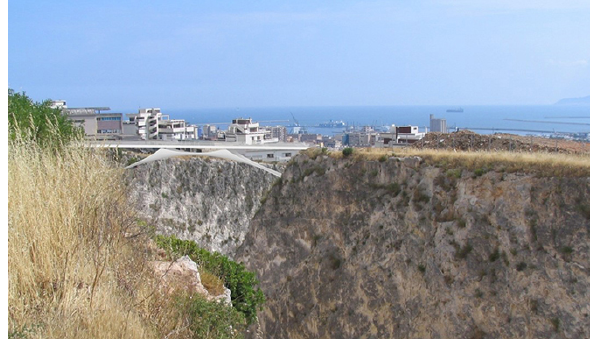
Figure 6: Photomontage of the shell-supported footbridge over Tuvixeddu canyon in Cagliari, Italy